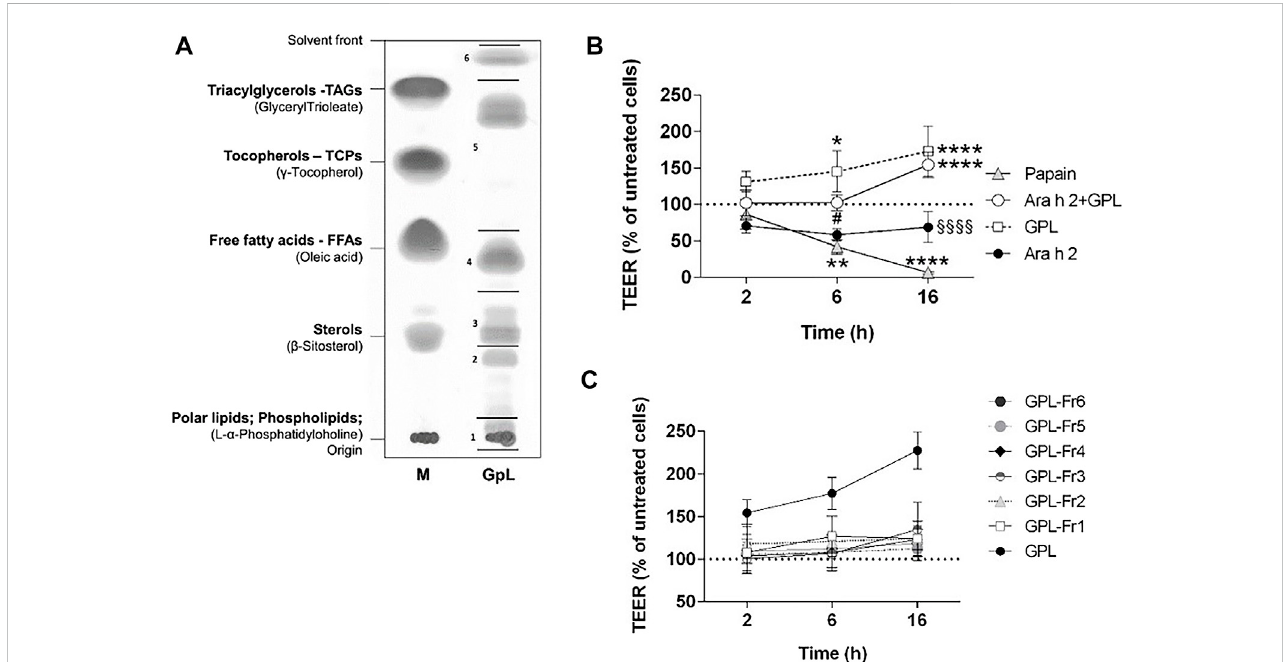
FIGURE 5 Impact of GPL and GPL-fractions on the TEER permeability of polarized 16HBE14o- cell monolayers. (A) TLC of GPL separated into major lipid classes in parallel to a lipid marker (M). The lipid samples loaded as markers are given in brackets, the corresponding major lipids classes are indicated in bold. GPL were separated into fractions indicated by black lines and numbers. (B) Cell monolayers were treated apically with GPL, Arah 2, and their combination. TEER values were measured after 2, 6, and 16 h and results are depicted as percentage of TEER of untreated cells (dashed line), papain was used as apositive control. Data represent the mean ± SD of three experiments. * p < 0.05, ** p < 0.01, *** p < 0.001. (*) indicates signi fi cance compared to untreated cells (negative control);(#)indicatessigni fi cancecomparedtoGPL;(§)indicatessigni fi cancecomparedtoArah2+GPL. (C) GPLfractionstogetherwithGPL,wereappliedto the apical compartments of cell monolayers and TEER was measured after 2, 6, and 16 h. Results are shown as the percentage of TEER of untreated cells (dashed line). Data represent the mean ± SD from three